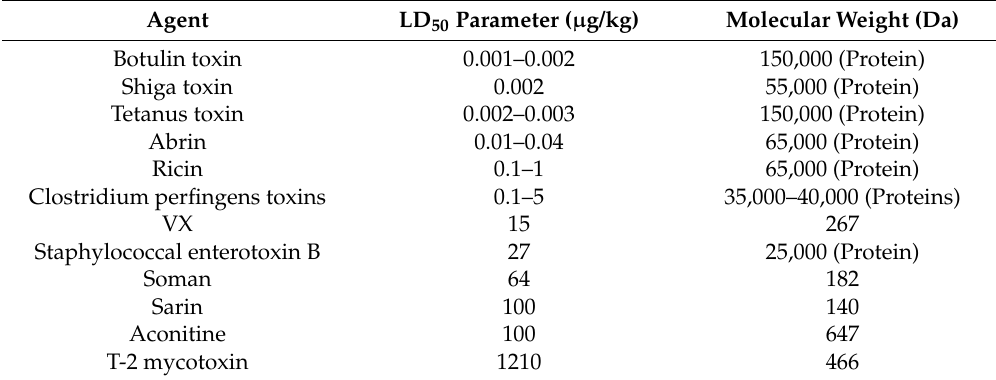
Table 1. Comparison of biological toxins toxicity with chemical warfare agents. Agent LD 50 Parameter ( µ g/kg) Molecular Weight (Da) Botulin